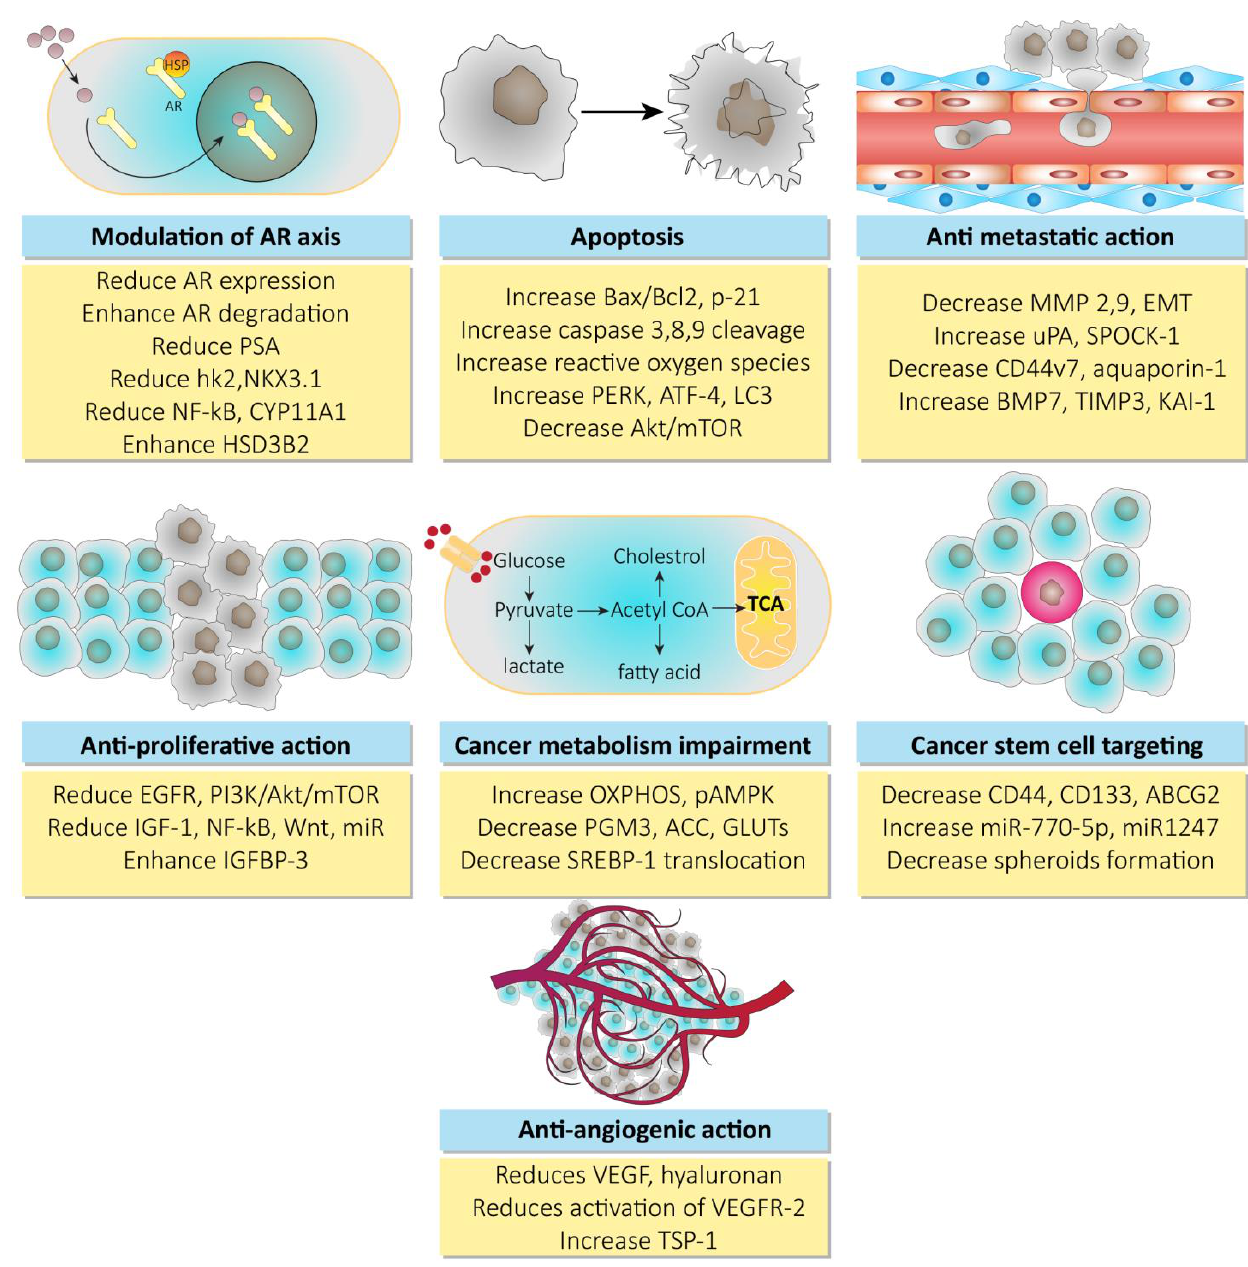
Figure 3. Mechanisms for anti-prostate cancer activity of natural products. Abbreviations: Hsp, heat shock proteins; AR, androgen receptor; PSA, prostate specific antigen; hK2, hexokinase-2; nKX3, homeobox protein; NF-kB, nuclear factor of kappa light chain for B-activated cells; HSD3B2, hydroxy delta-5-steroid dehydrogenase 3-beta delta isomerase 2; EGFR, epidermal growth factor receptor; PI3K, phosphoinositide 3 kinase; Akt, serine/threonine specific protein kinase; mTOR, mammalian target of rapamycin; IGF-1, insulin like growth factor-1; Wnt, wingless int-1; IGFBP3, insulin like growth factor binding protein 3; Bcl-2, B-cell lymphoma-2; PERK, protein kinase RNA like endoplasmic reticulum kinase; ATF-4, activating transcription factor-4; LC3, light chain-3; OXPHOS, oxidative phosphorylation; pAMPK, phosphorylated adenosine monophosphate activated protein kinase; PGM3, phosphoglucomutase 3; ACC, adenoid cystic carcinoma; SREBP- 1, sterol regulatory element binding protein-1; MMP, matrix metalloproteinase; EMT, epithelial mesenchymal transition; uPA, urokinase plasminogen activator; SPOCK-1, sparc osteonectin cwcv kazal like domain proteoglycan (testican-1); BMP7, bone morphogenetic protein 7; TIMP3, tissue inhibitor of metalloproteinase 3; ABCG2, ATP binding cassette transporter G-2; VEGF, vascular endothelial growth factor; VEGFR2, vascular endothelial growth factor receptor-2; TSP-1, thrombospondin-1.